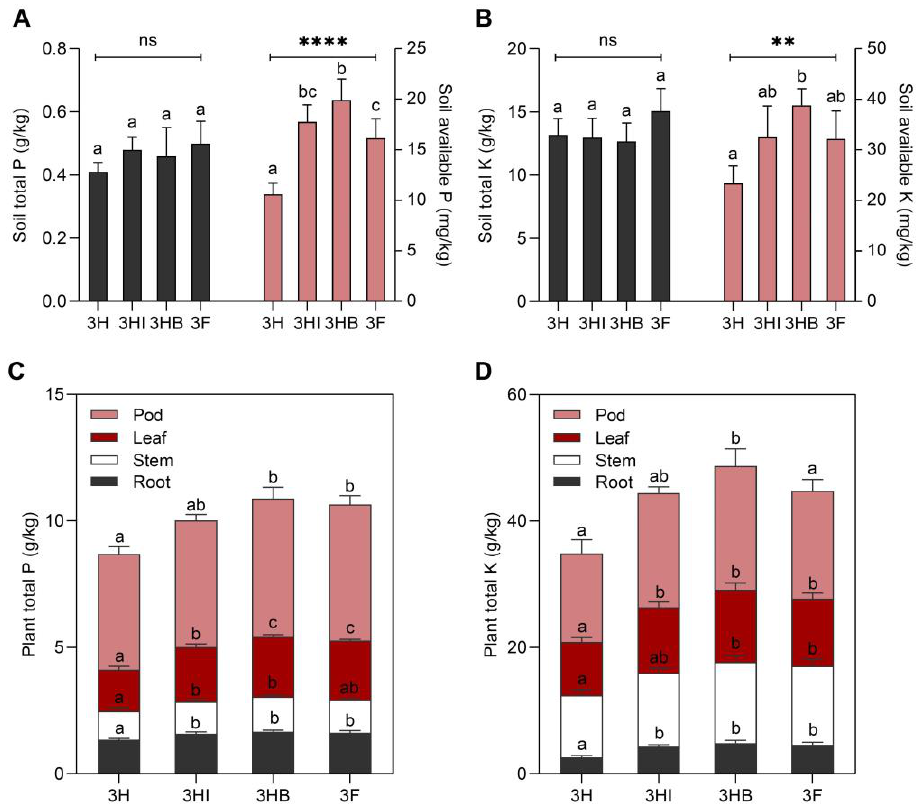
Figure 1. Effect of free-cell and encapsulated E. hormaechei 40a on soil P and K status after 60 days grown under greenhouse conditions. ( A ) soil total P; ( B ) soil total K; ( C ) plant total P; ( D ) plant total K. Data (mean ± standard deviation, n = 4) followed by different letters between treatments indicate significant differences (one-way ANOVA + Tukey multiple comparisons test at p ≤ 0.05). p -value